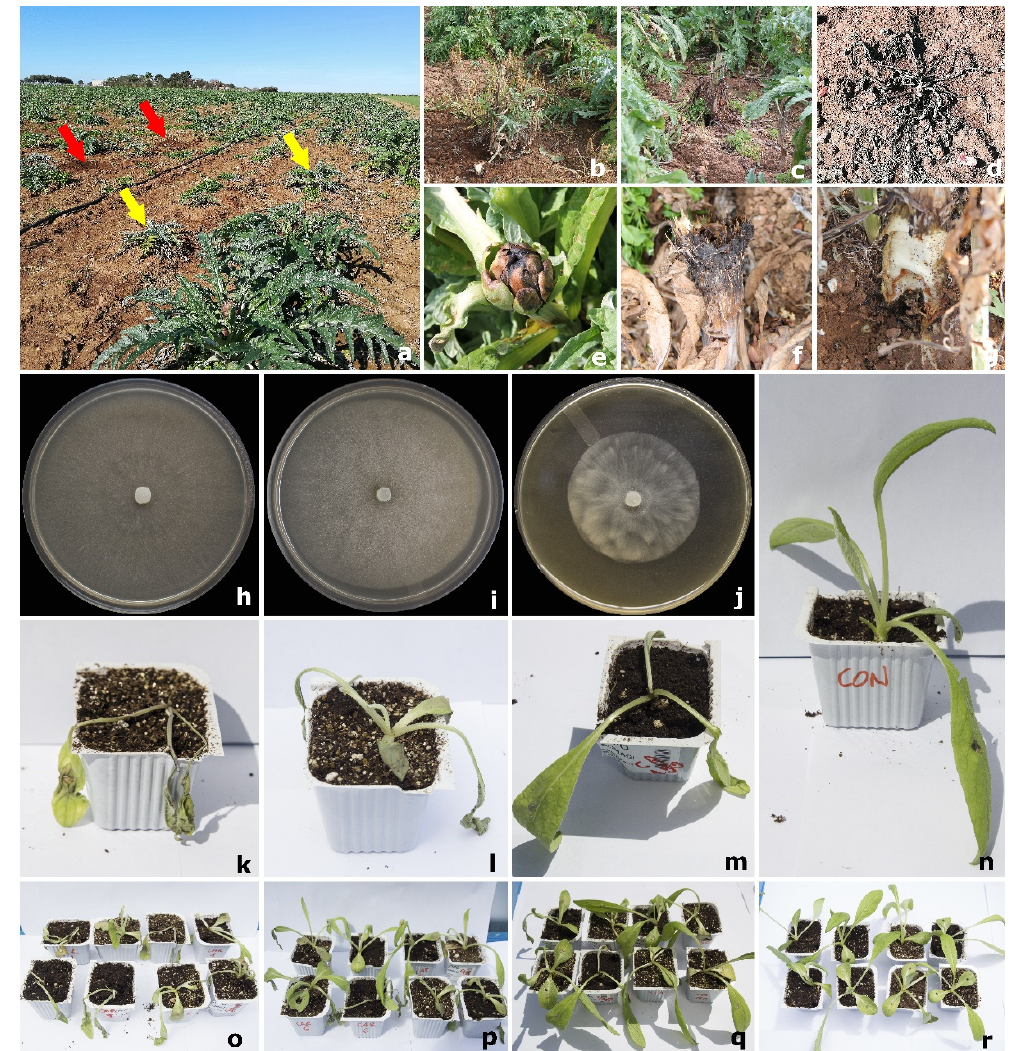
Figure 1. Overview of disease symptoms observed on globe artichokes: artichoke plantation severely impacted by the disease: red arrows indicate dead plants, whereas yellow arrows indicate plants with stunted growth and leaf symptoms ( a ); progressive wilting symptoms ( b – d ); dark brown lesions on bracts, basal stem and roots ( e – g ). Colony morphology of Phytophthora cactorum ( h ), P. crassamura ( i ), and P. marrasii ( j ) after 7 days growth at 25 °C on CA in the dark. Symptoms observed on globe artichoke plants 5 days after inoculation with P. cactorum ( k , o ), P. crassamura ( l , p ), and P. marrasii ( m , q ). Control plants ( n , r ).